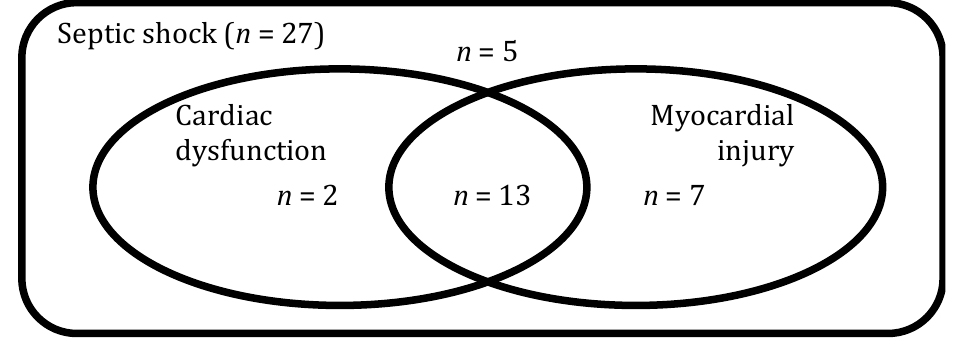
Figure 1. Septic cardiomyopathy phenotypes. Venn diagram depicting the number of patients with myocardial injury (hscTnT > 14 ng/L) and cardiac dysfunction (LVEF < 50% or cardiac dysfunction requiring treatment with inotropes). For more details, please refer to Materials and Methods. n —number of patients. Table 1. Patient characteristics at ICU admission. Part I. Data are presented as median (interquartile range) or number (percentage). BMI—body mass index.